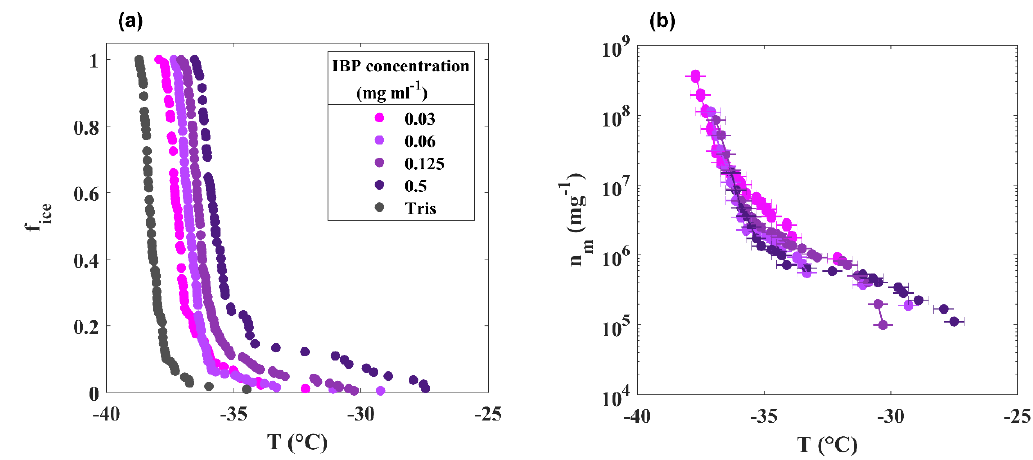
Figure 9. Ice nucleation of IBP solutions. ( A ) Frozen fraction as a function of temperature for various IBP concentrations (purple shades) and the Tris buffer (dark grey). ( B ) The density of ice-active sites (n m ) per IBP mass as a function of temperature.